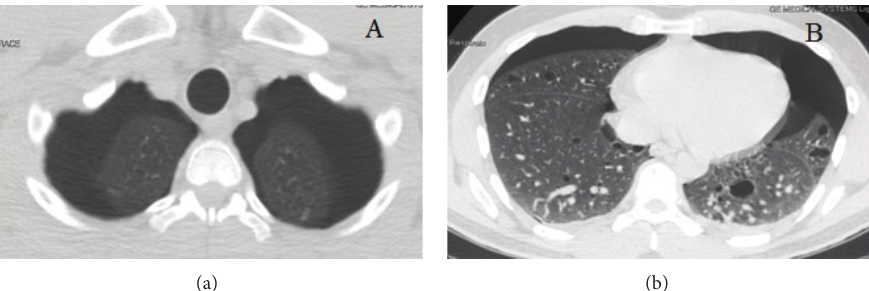
Figure 1: Chest CT-scan showing the apical (a) and the basal (b) aspect of the simultaneous bilateral spontaneous pneumothorax, as well as the multiple lung cysts (b).